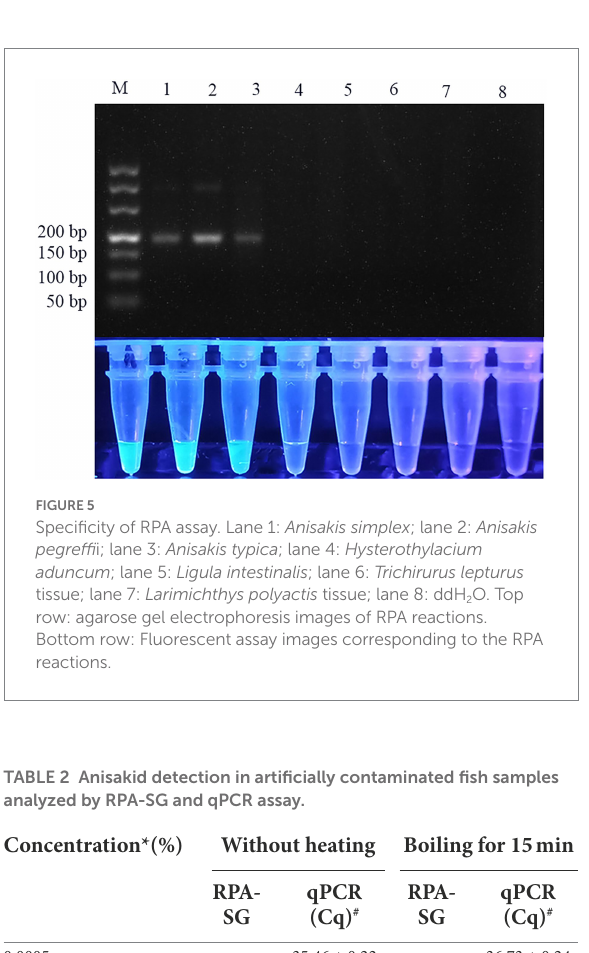
TABLE 2 Anisakid detection in artificially contaminated fish samples analyzed by RPA-SG and qPCR assay. Concentration*(%)